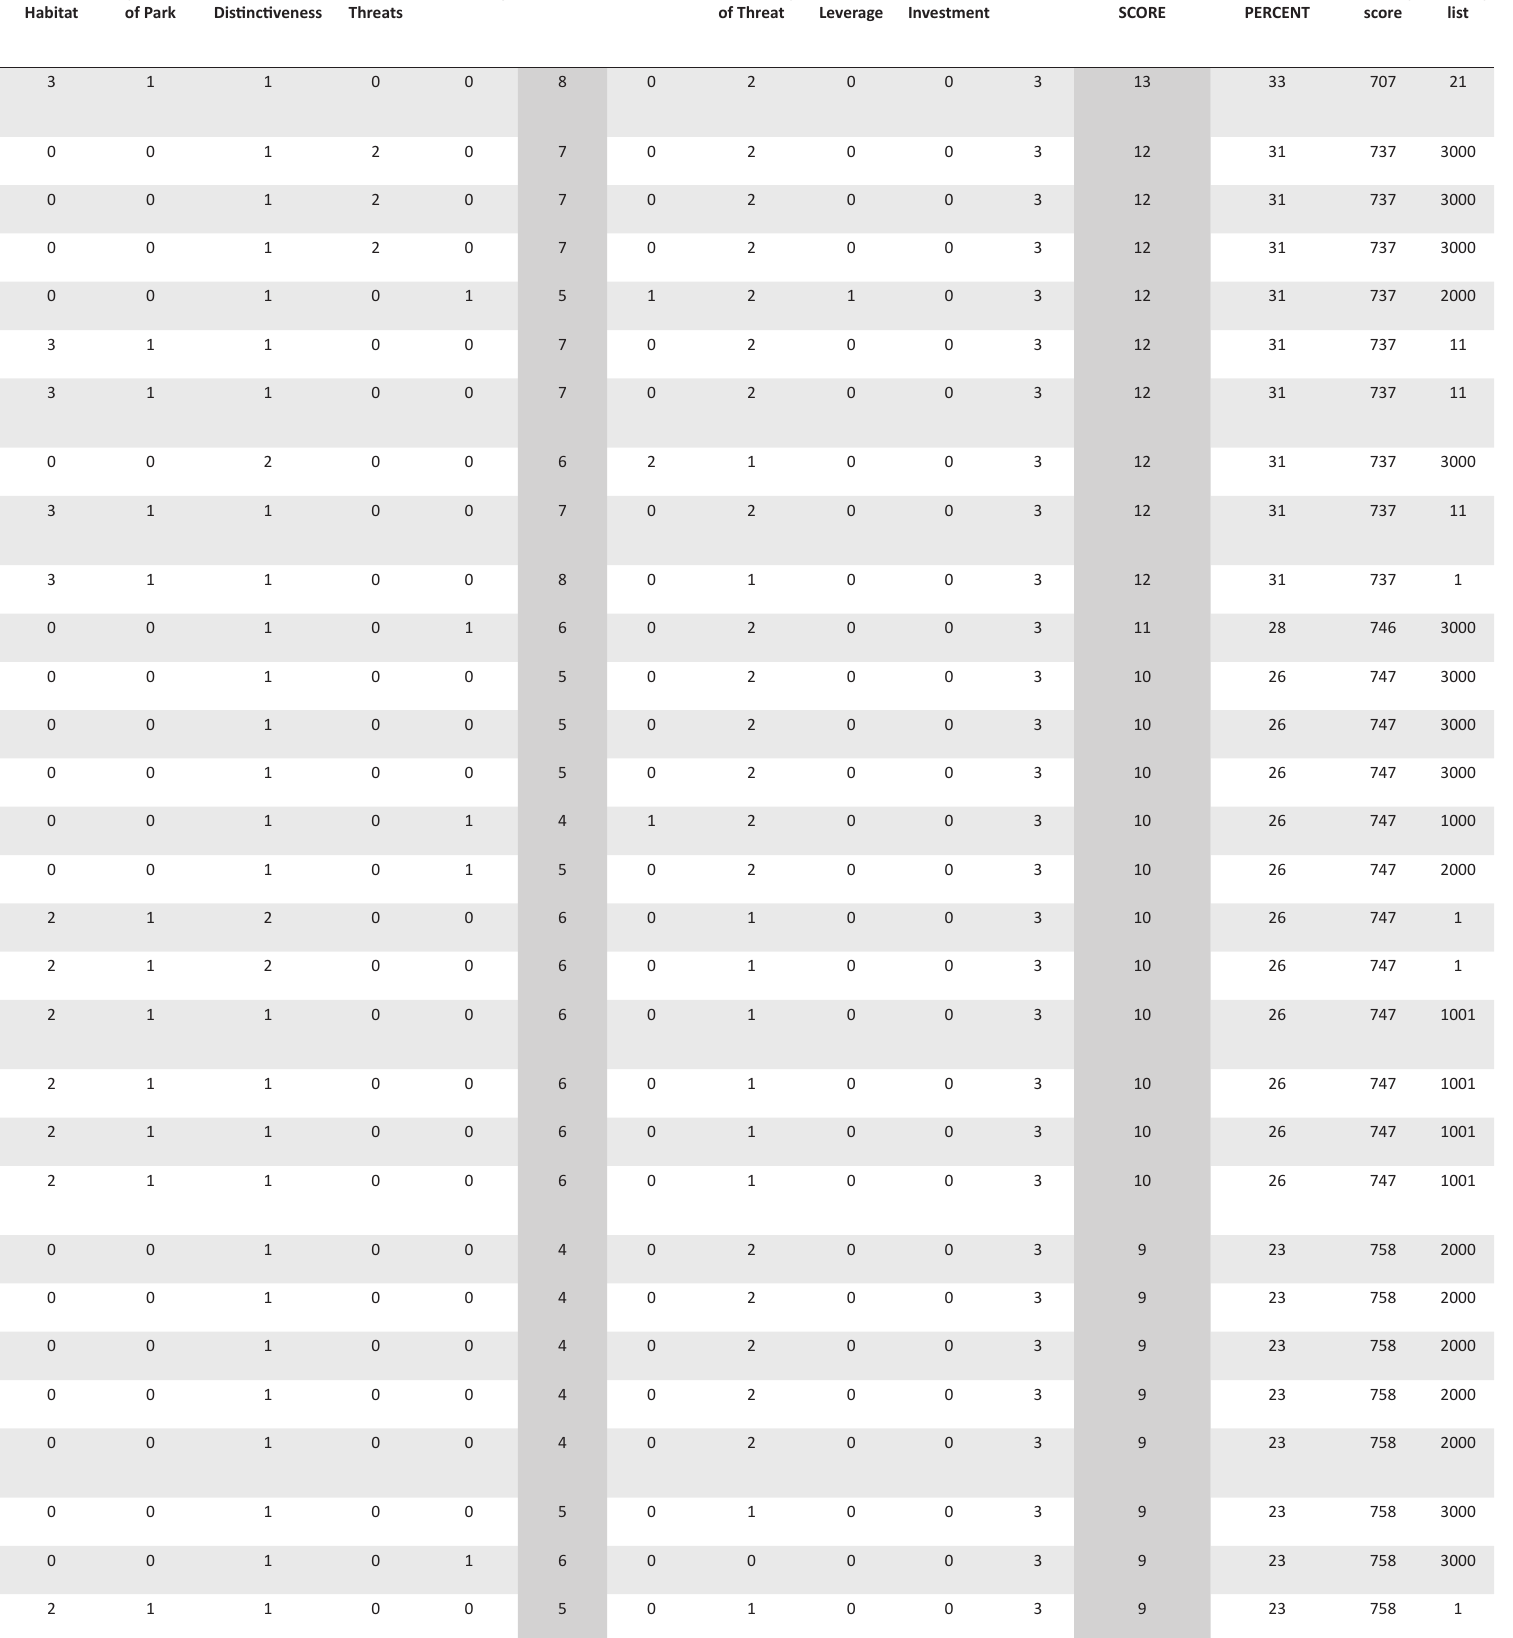
Online Appendix Table 1 (Continues...): List of species of Special Concern in the Table Mountain National Park and associated scores Species